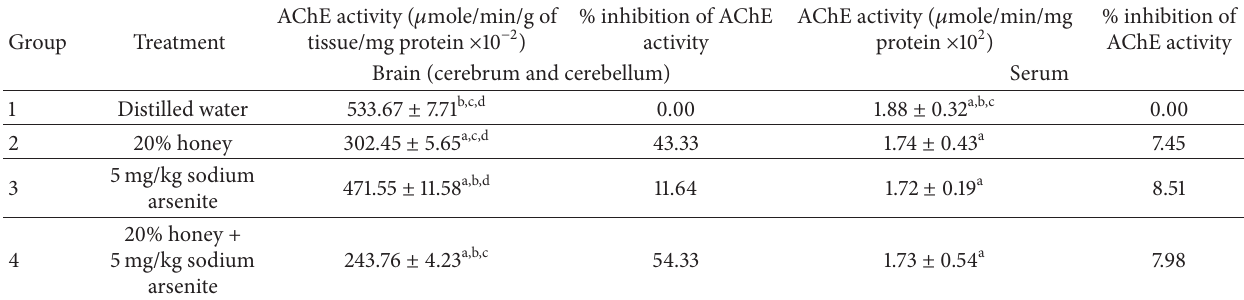
Table 1: The activity of AChE versus the percentage (%) inhibition in the brain (cerebrum and cerebellum) and serum after Acacia honey and sodium arsenite administration in vivo .